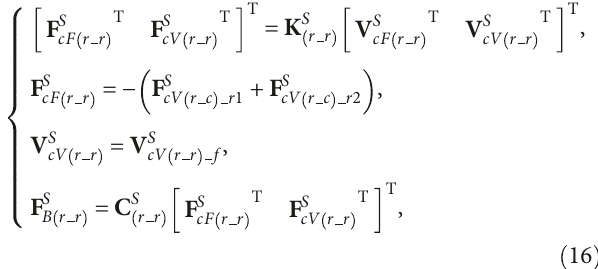
Table 2: Statistical characteristics of assembly variations. Mean Point Direction